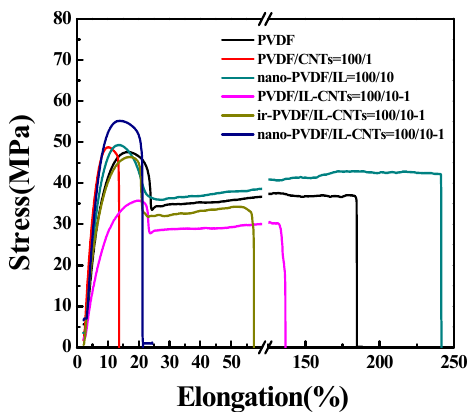
Figure 8. Strain-stress curves of neat PVDF, PVDF/CNTs (100/1), PVDF/IL-CNTs (100/10-1), ir-PVDF/IL-CNTs (100/10-1), and nano-PVDF/IL-CNTs (100/10-1).